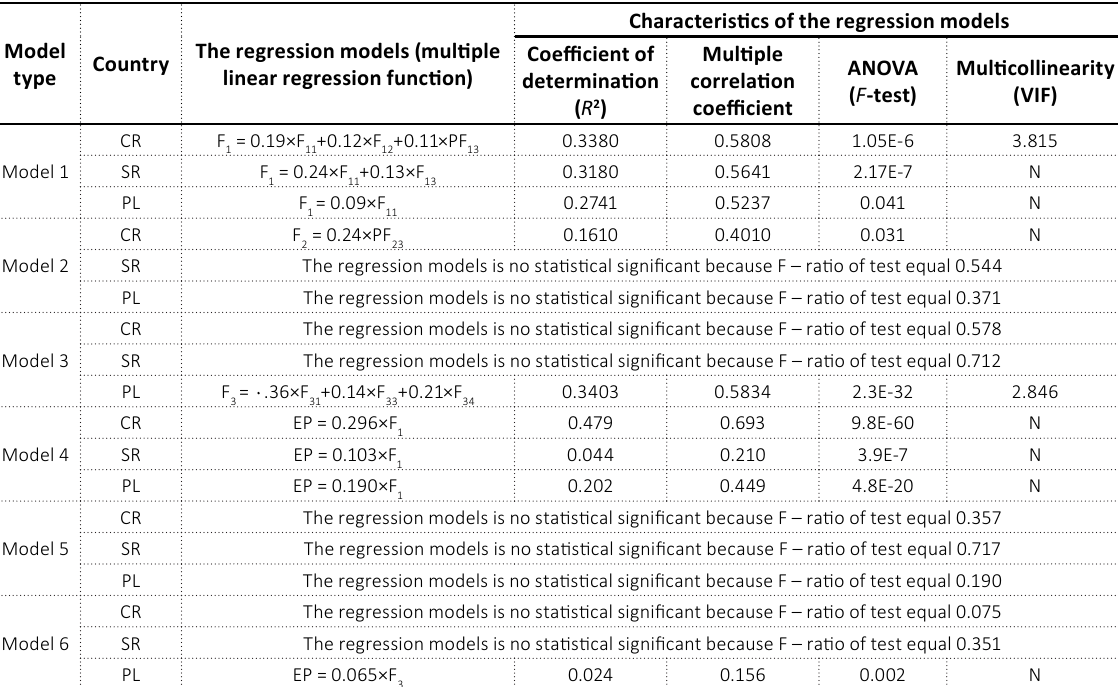
Table 4. Characteristics of entrepreneurial propensity of regression models